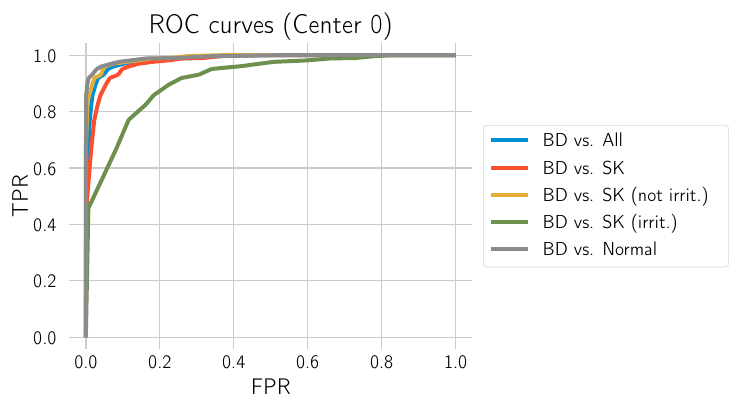
Figure 13. ROC curves for the test set from Center